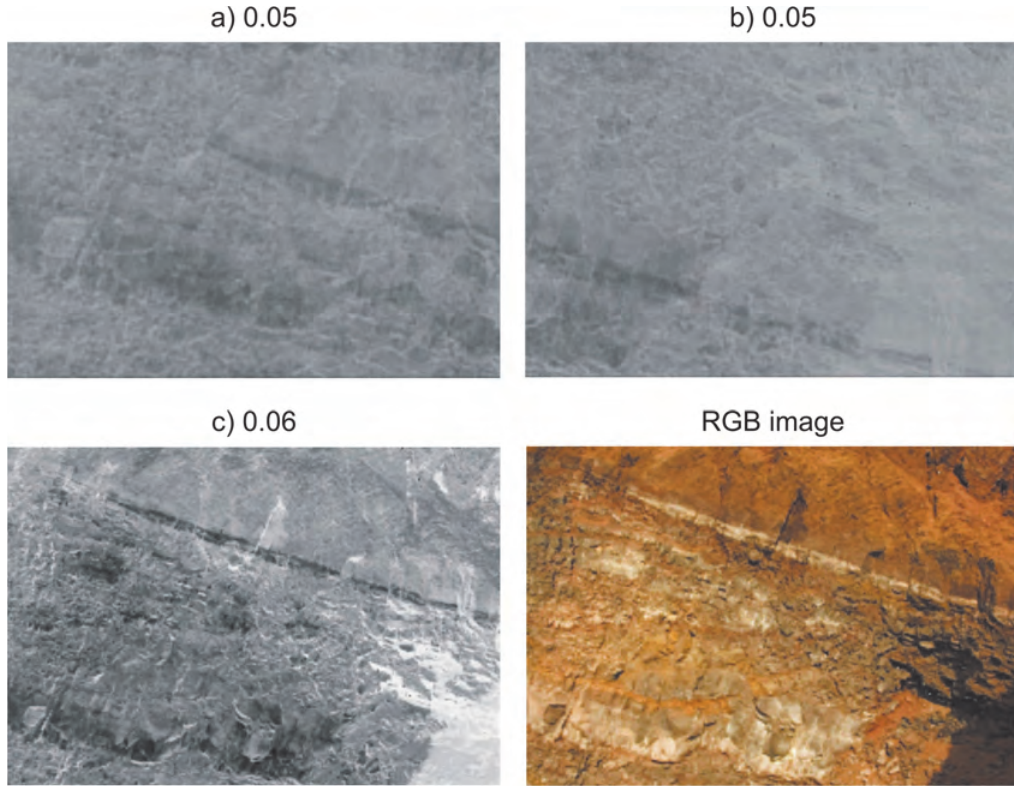
Fig. B1. Principal component analysis of the RGB image of a selected part in the B-zone: the principal compo- nents (a, b), a virtual image obtained choosing 0.06 variance (c), the initial RGB image